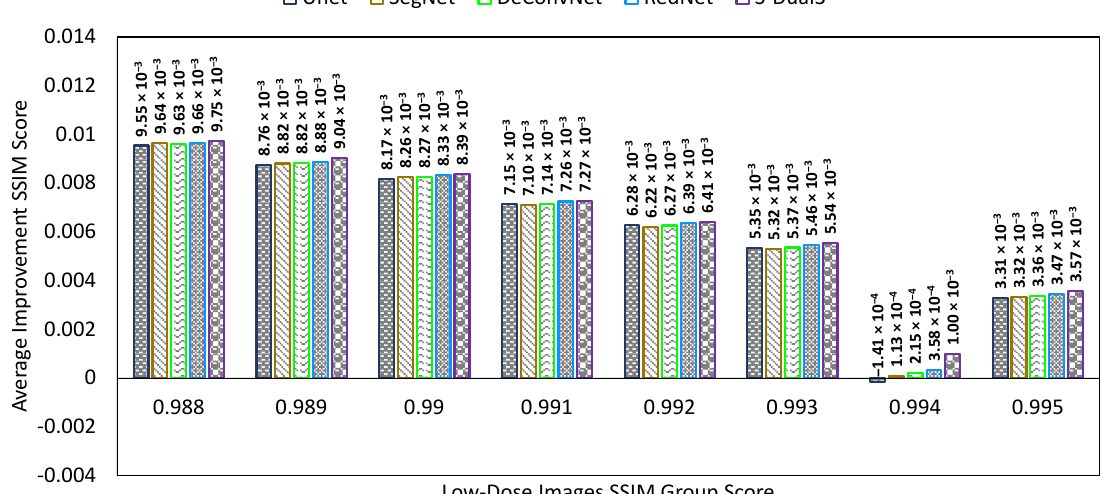
Figure 17. Comparison chart of SSIM scores from different CNN models with a new data set. This training result was tested against the actual screening image showing each method’s denoising quality. The screening dataset was obtained from National Lung Screening Trial research [40], stored in the Cancer Imaging Archive (TCIA) library [41]. We run the test using seven methods, since the BM3D requires a good image to calculate the standard deviation. Figure 18 shows that the NLM method left a trace of noise, the Gaussian caused a little image blur, and the SegNet, and DeConvNet shared the same spotty pixels i the solid area upper left and right and had contrast enhancement. The last three images had similar results to the RedNet, and UNet had higher contrast enhancement than the S-Dual3.